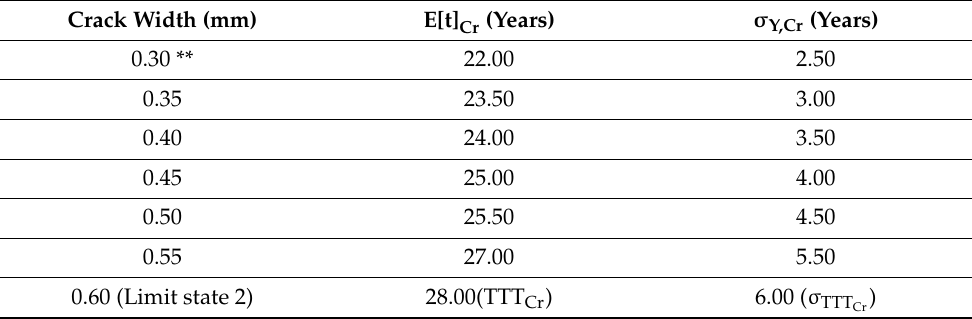
to reach a certain crack length and the corresponding σ Y,Cr Cr